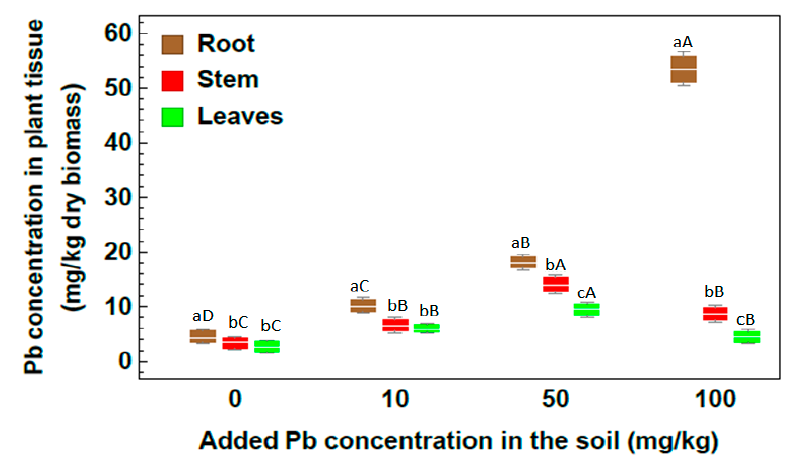
Figure 4. Concentration of Pb in plant organs of Rhazya stricta grown in soil treated with 10, 50 and 100 mg Pb/kg soil in an open greenhouse. Different lowercase letters indicate significant differences between plant parts for each soil metal concentration, and different capital letters indicate a significant difference between soil metal concentrations for each plant part ( p < 0.05).